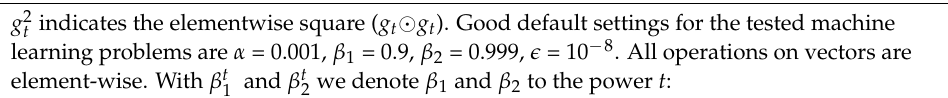
Algorithm 1. The calculation process and pseudocode of Adam